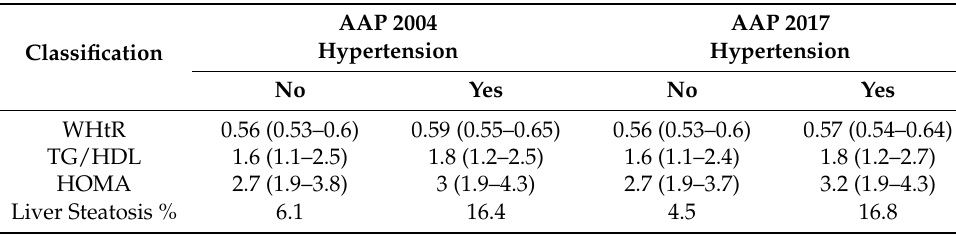
Table 3. Median value (inter quartile range) and subjects with liver steatosis in children classified according to AAP 2004 and AAP 2017 blood pressure